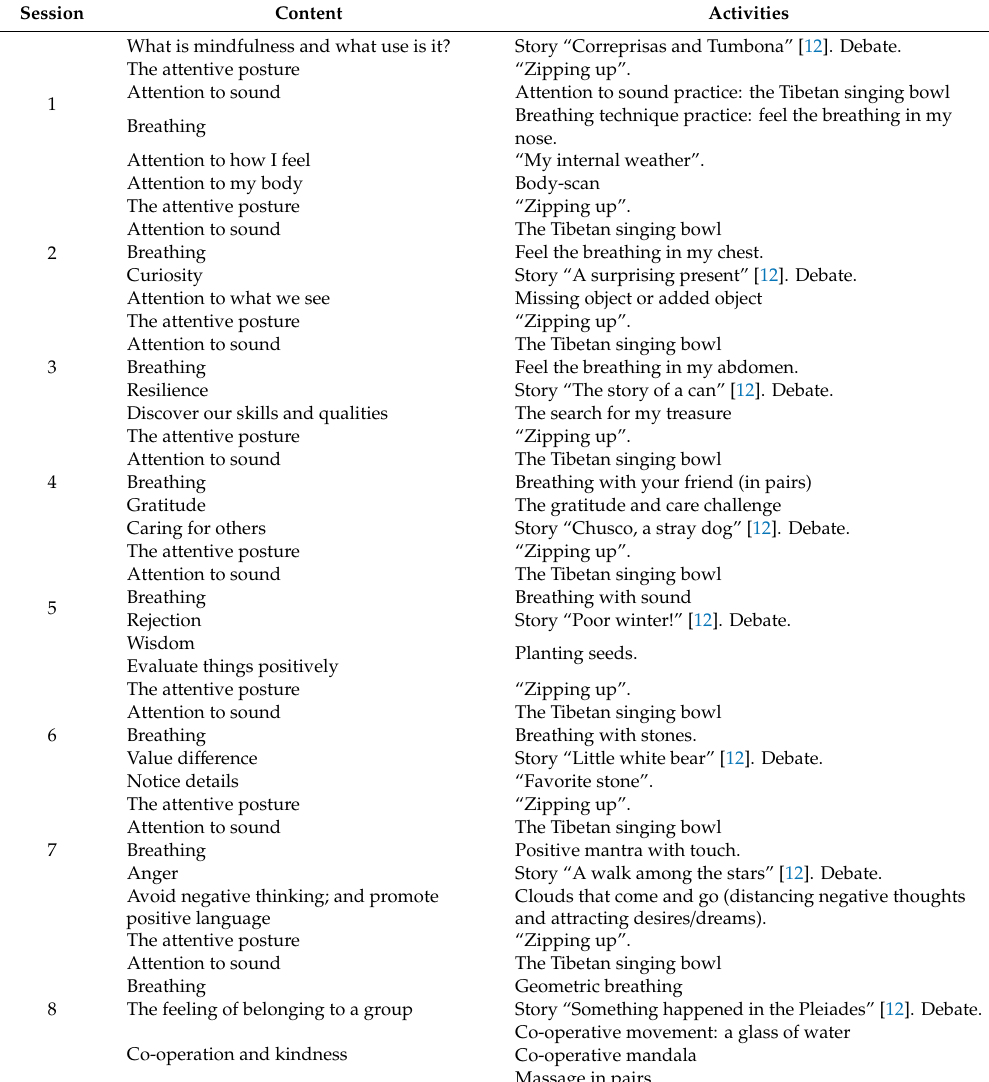
Table 4. The content of eight mindfulness-based sessions for